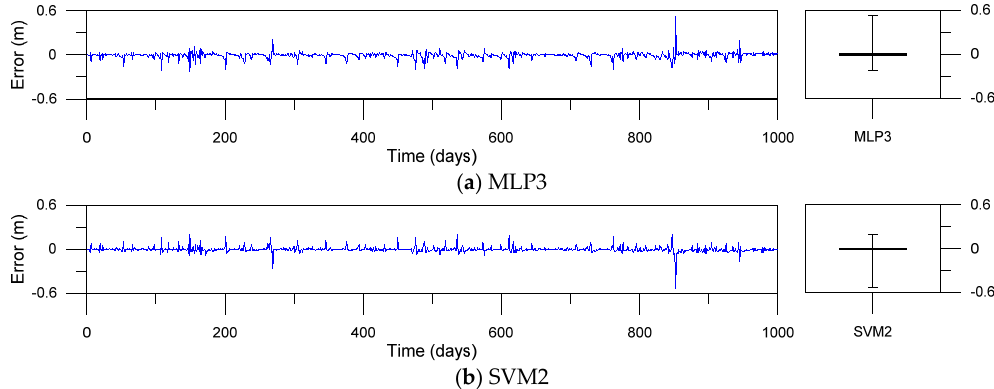
Figure 12. Error time series plots and error boxplots for the MLP and SVM models.